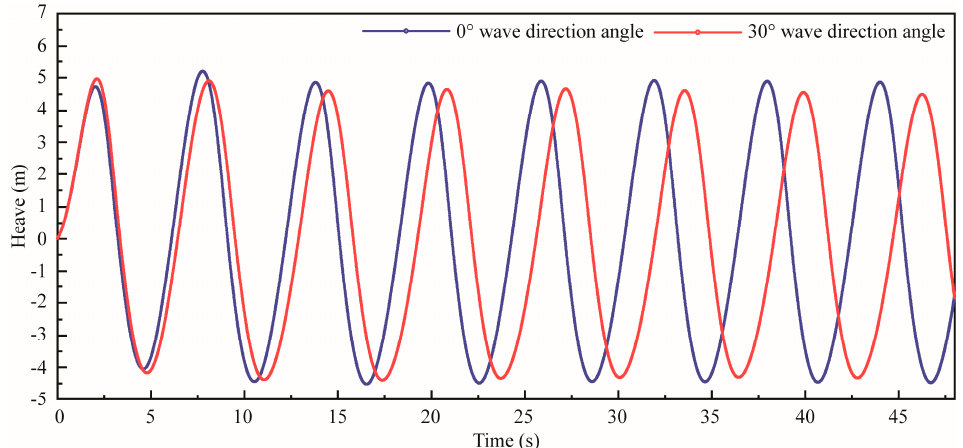
Figure 13. The heave motion with different wave direction angles at 7 level sea state.